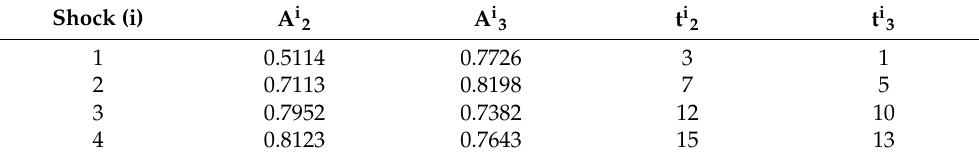
Table 10. Availability and time values used to perform the resilience